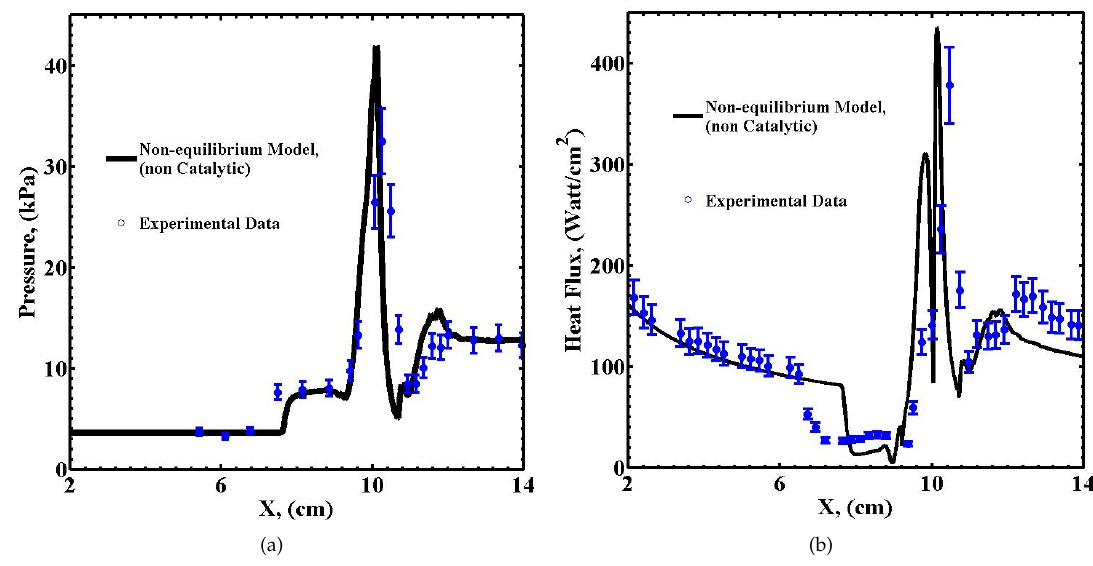
Figure 7. Computational results for Run 2, Table 1, using the non-equilibrium Navier–Stokes model.